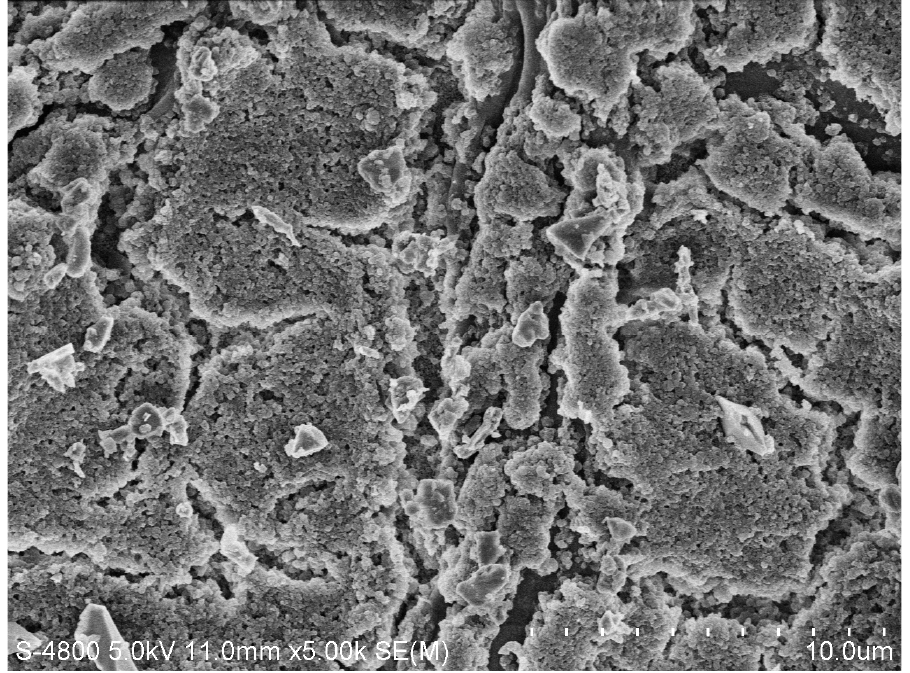
Figure 9. Photograph of the ZrO membrane with intermittent ultrasound after filtration of 2 the TBL (with intermittent ultrasound), magnification